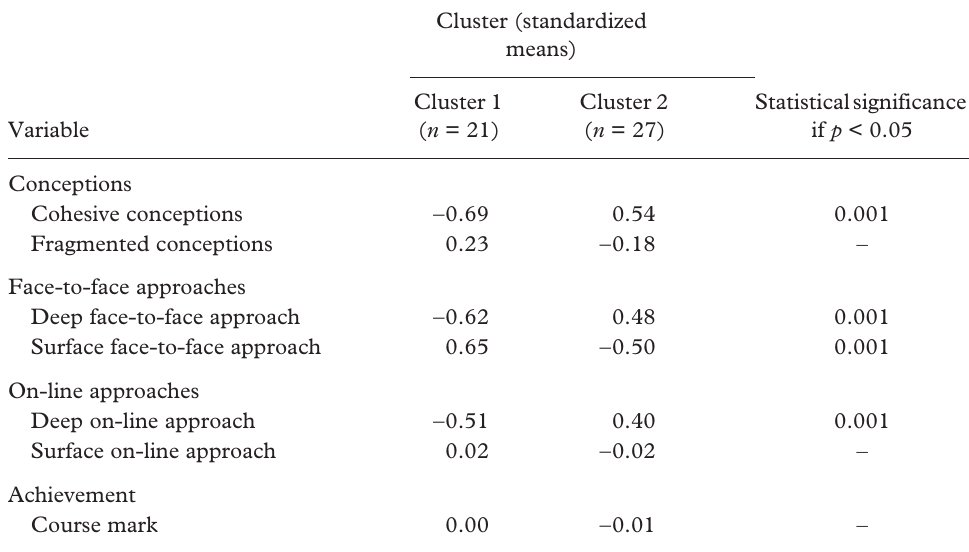
Table 4. Cluster analysis of parts of the student learning experience and achievement ( n = 48) Cluster